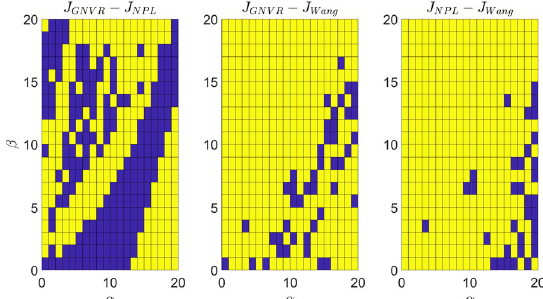
Fig. 24 Cost Function Difference between NPL, GNVR and Wang Shapes